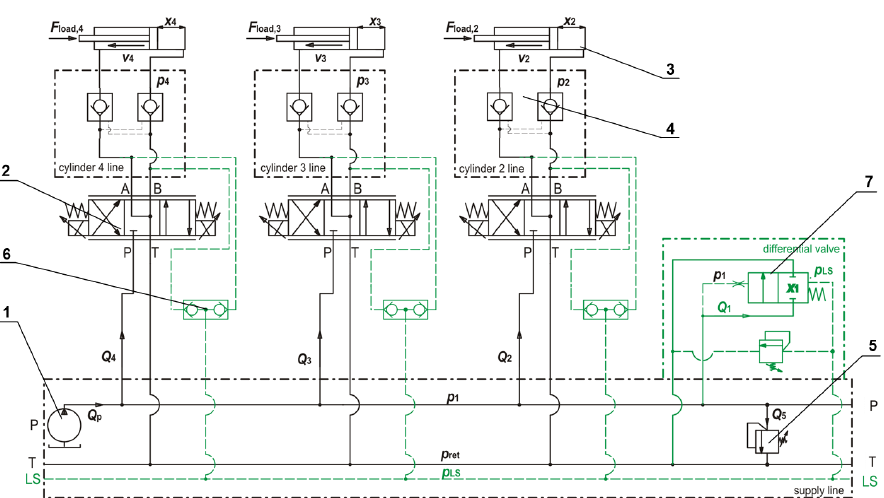
Figure 1. Scheme of the analysed hydraulic system: 1—pump, 2—proportional control valve, 3— hydraulic cylinder, 4—hydraulic lock, 5—relief valve, 6—logic valve, 7—differential valve; black colour—base system, green colour—proposed LSB